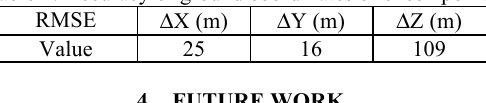
Table 2. Accuracy of ground coordinates of check points